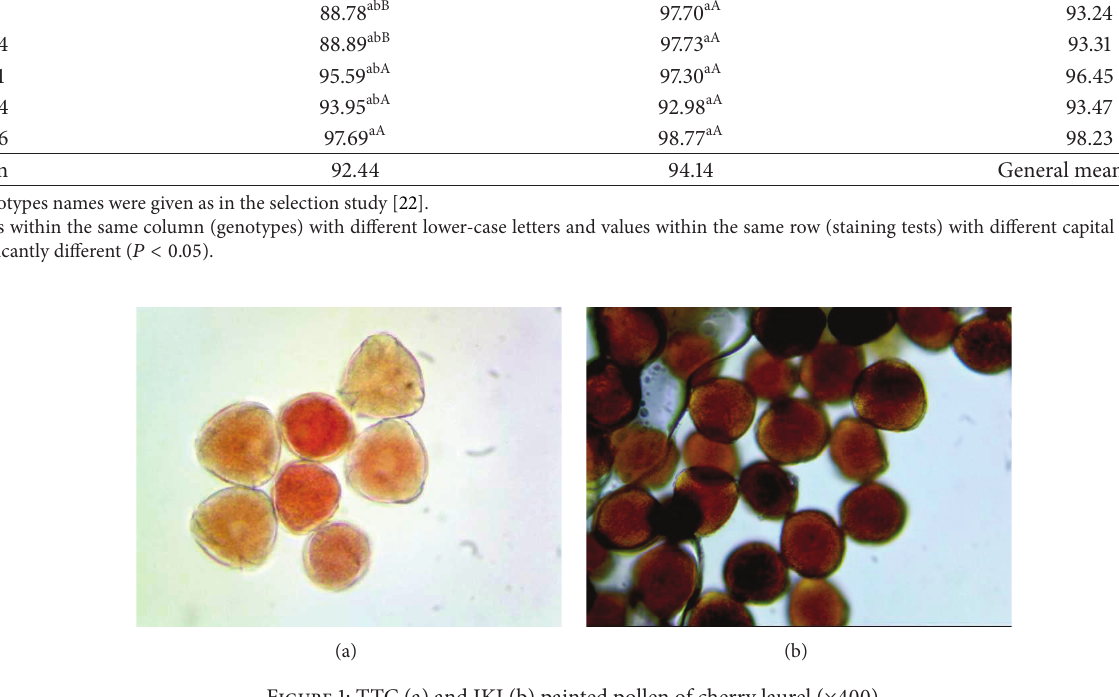
Figure 1: TTC (a) and IKI (b) painted pollen of cherry laurel ( ×